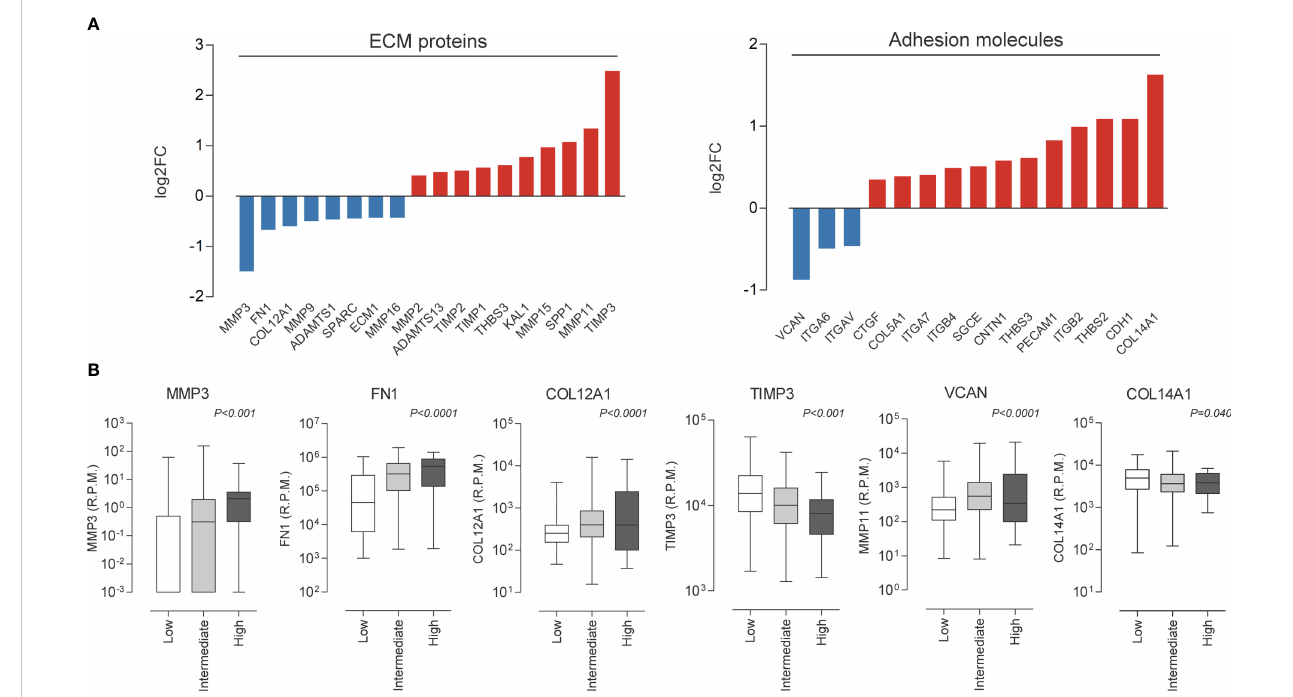
FIGURE 7 miR-495-3p overexpression modulates migration/adhesion related genes. (A) Bar plots show genes modulated by miR-495-3p overexpression. We considered modulated, genes from the Human Extracellular Matrix and Adhesion Molecules plate whose expression suffered a 0.25 alteration on fold- change. (B) Box plots show association between the expression of some genes shown on “ a ” and risk on PTC (TCGA data downloaded from